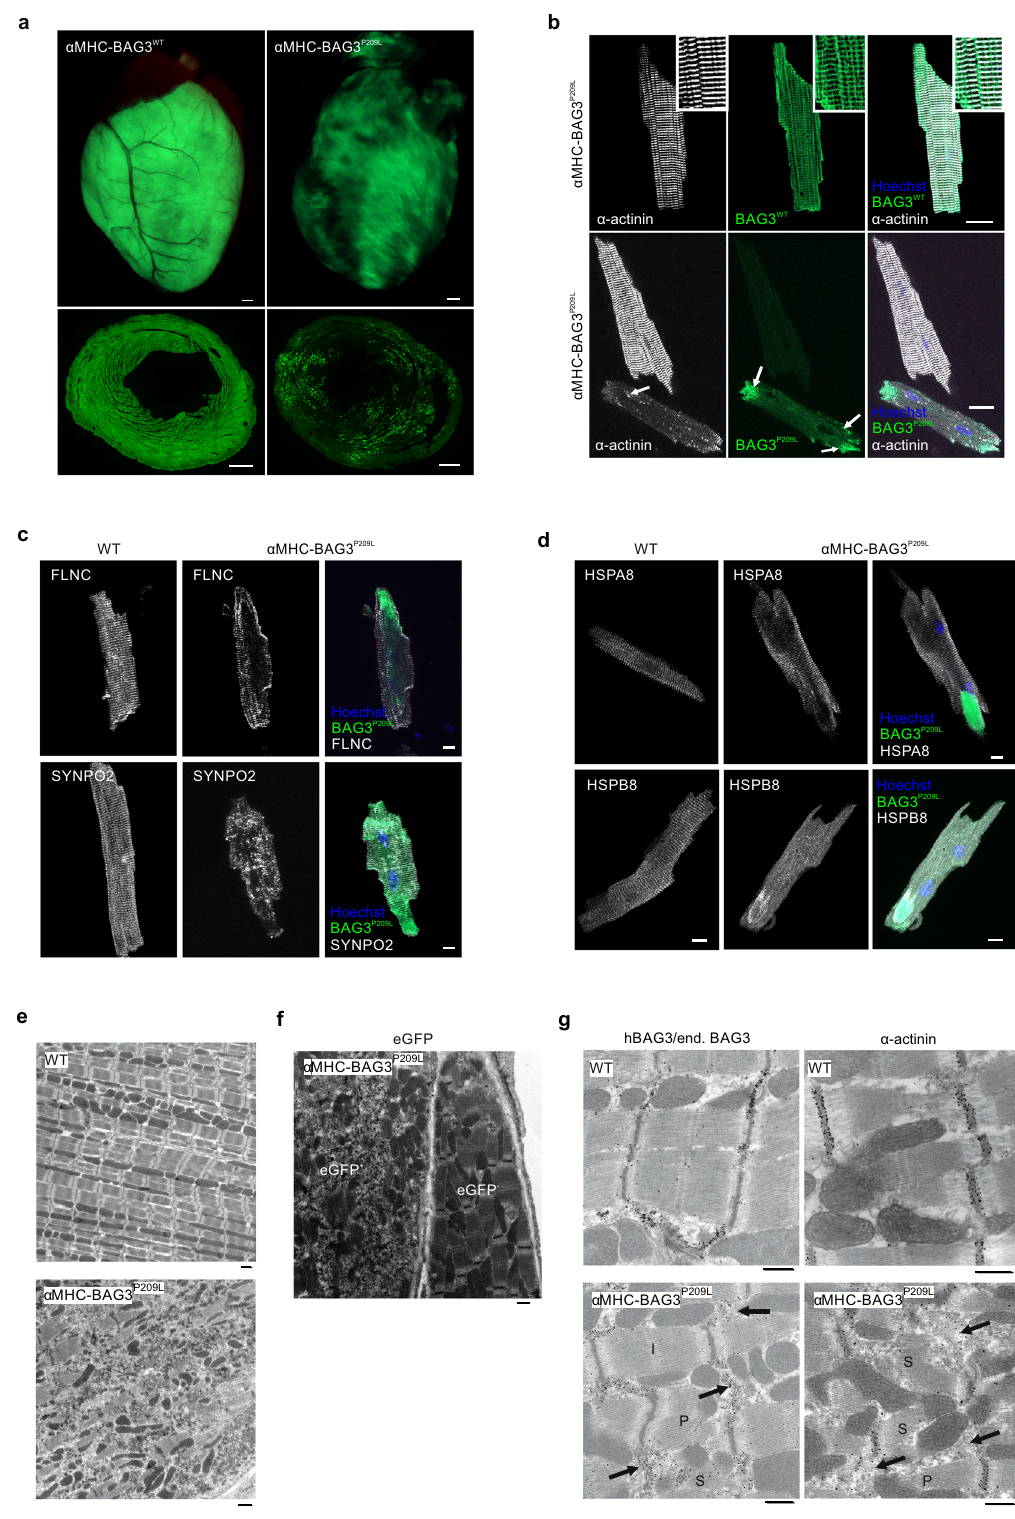
early mortality. This was most likely due to the low degree of penetrance (36.28 ± 5.56% of CMs) of the transgene. Overexpression of human BAG3 P209L causes restrictive cardi- omyopathy . Because of the obvious limitations of our α